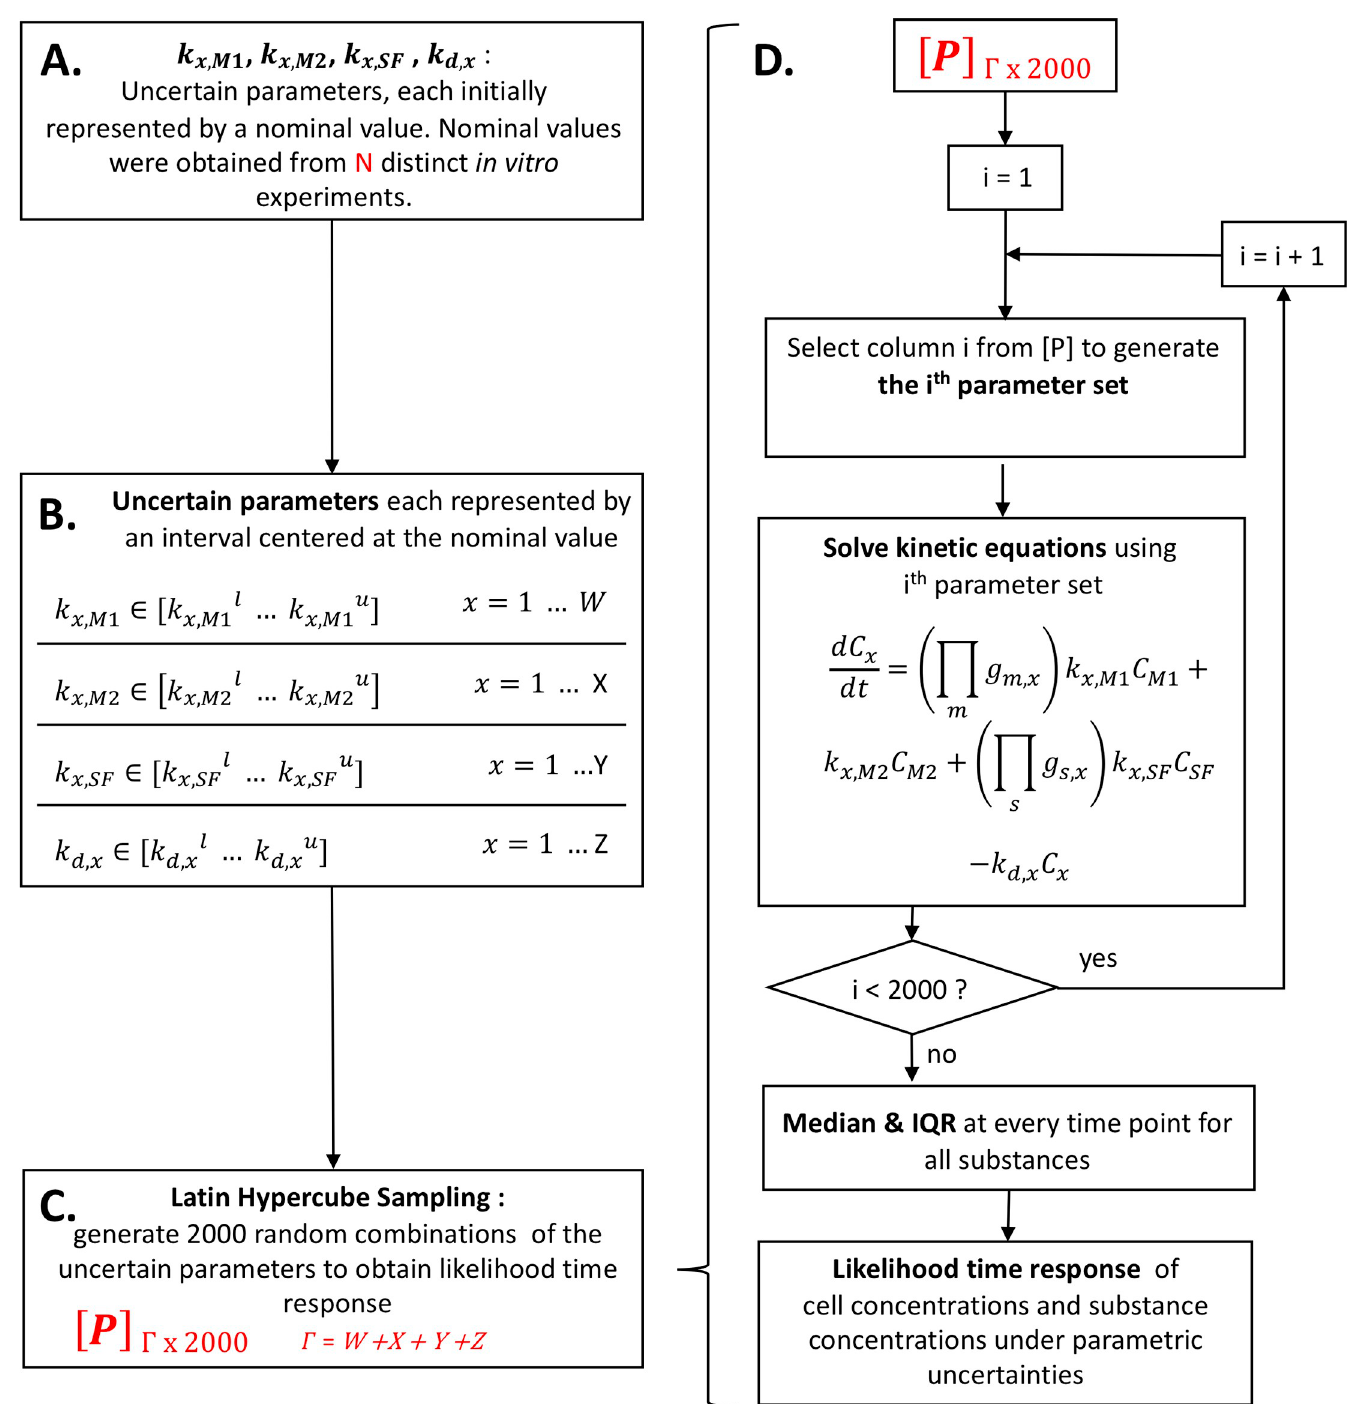
Fig 2. Summary of model formulation process. A. Estimation of Nominal Parameter Values. The first step in the modeling process was to estimate the nominal production and decay rate coefficients (see section 2.1) from N = 23 published in vitro studies (cited in S1 Table). B. Parametric Variations. We varied these parameters between 40% and 160% ( ± 60%) of their nominal values, generating a 2000 element row vector associated with every parameter. The values in these row vectors were evenly spaced and sorted in ascending order. C. Parameter Matrix [P]. Next, we randomized the order of each individual row vector before stacking the vectors into a Γ by 2000 matrix, [P], where Γ represented the number of nominal parameters (and, therefore, the number of row vectors) in the model. Because of the randomization and stacking, each individual column in [P] represented a randomly varied parameter set that we could use in the differential equations. D. Latin Hypercube Sampling Process. We selected column i from [P] to generate the ith parameter set and solved the differential equations. After solving the equations with all